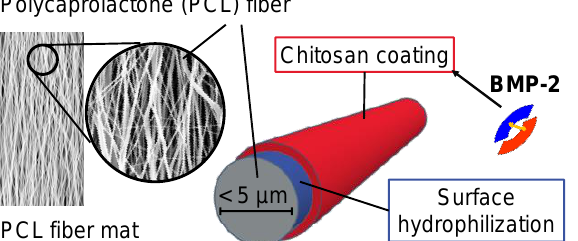
Figure 1. Schematic structure of the implant prototypes with a bone morphogenetic protein 2 (BMP-2)-containing chitosan coating. A detailed study on the coating mechanism and the resulting structure of the polyelectrolyte coating was performed by Sydow et al. [28].